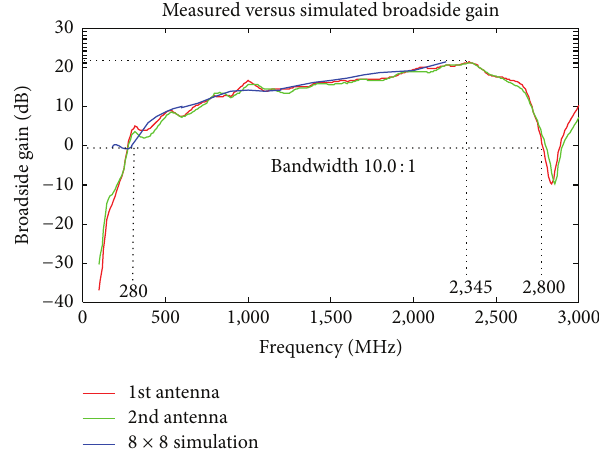
Figure 11: Measured and simulated realized gain at broadside (co- pol/E-pol data) for the TCDA-IB array whose geometry is presented in Figures 5–10. The agreement among all 3 gain curves provides substantial confidence in the validity of the measured performance. Small fluctuations in the realized gain are attributed to the horn used for calibration during measurements.